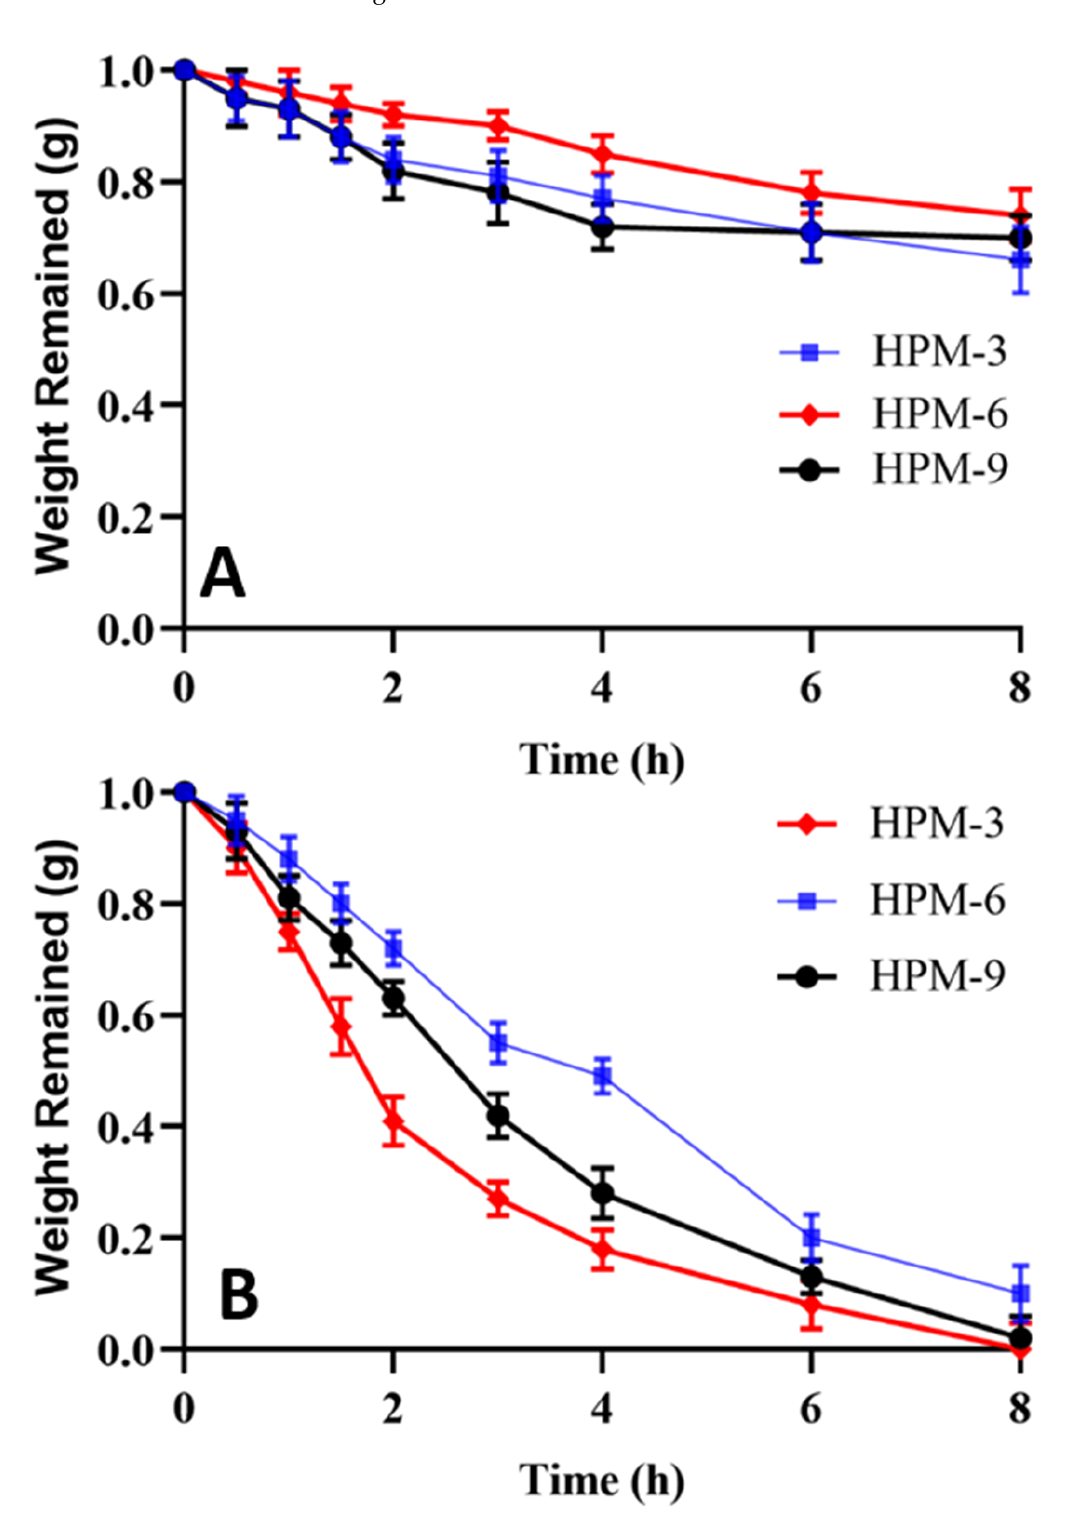
Figure 13. In vitro degradation studies at ( A ) AGF (pH 1.2) and ( B ) AIF (pH 6.8).